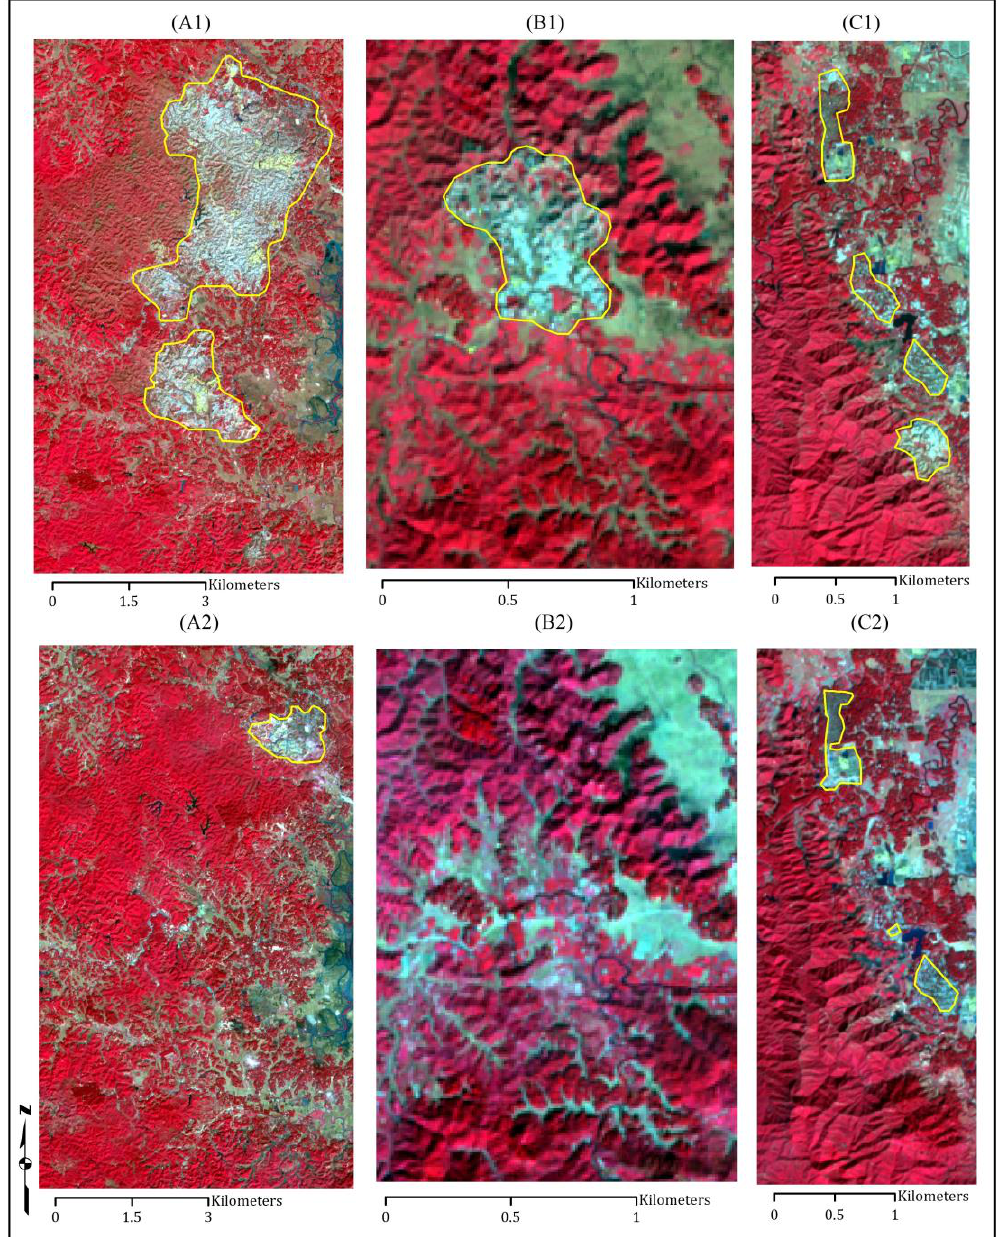
Figure 3. False color composite images of the three camp study sites between pre- and post-August of 2017. The columns are aligned to represent the three different camps (i.e., camps A, B and C) while the rows represent the two-time steps. The first row of images was taken in December 2017, depicting the post-August refugee influx: ( A1 ) Kutupalong–Balukhali camps; ( B1 ) Unchiprang camp; and ( C1 ) Nayapara–Leda camp area. The second row of images ( A2 , B2 and C2 ) are from December 2016, showing the same camps and surrounding areas as the A1, B1 and C1 images, respectively, prior to the mass influx of Rohingya refugees in August of 2017. The yellow polygons drawn on the images highlight the gray spectral reflectance representing the three refugee camp sites, and show a large-scale physical expansion in the first row of images (December 2017) compared to the second row of images (December 2016). In these false color composite images, red depicts forestland; dark blue indicates water, and brown represents soil/nonforest.